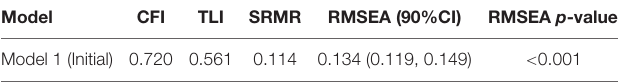
TABLE 2 | Model Fit Indices for model of initial structural model.